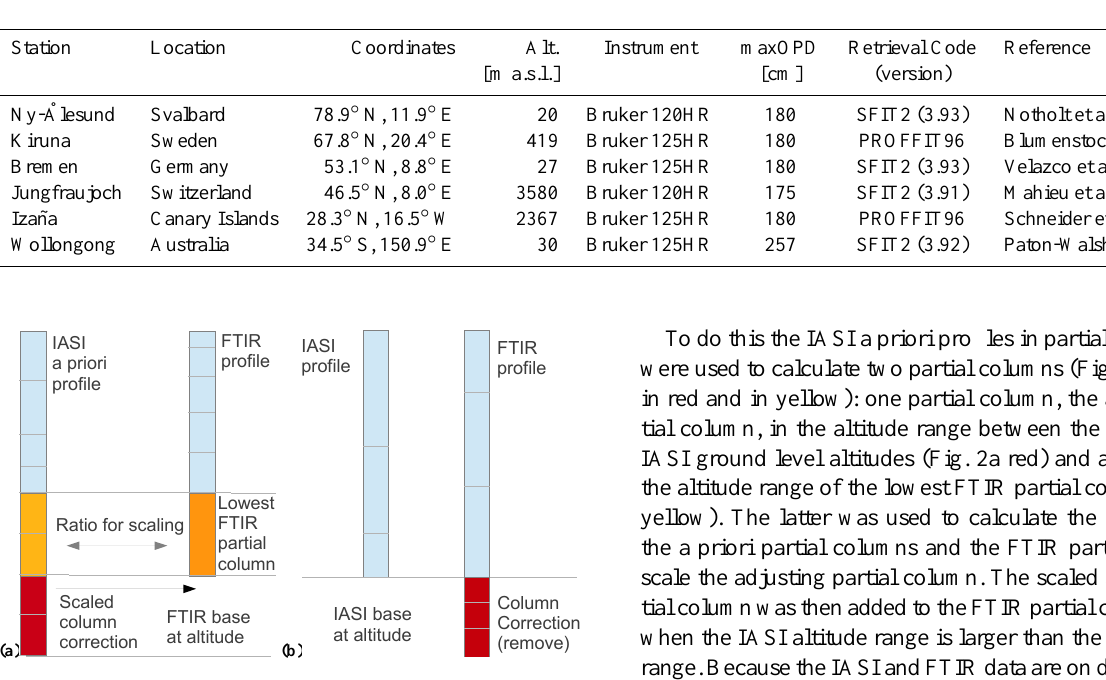
Fig. 2. Altitude adjustment for the cases where the base of the ground-based FTIR spectrometer measurements is at a higher (a) or at a lower altitude (b) than the IASI ground pixel. The adjusting partial column is indicated in red; in (a) it is added to and in (b) sub- tracted from the FTIR column. The partial columns to calculate the scaling factor in (a) are indicated in yellow. The calculations were done using a combination of the FTIR and IASI altitude